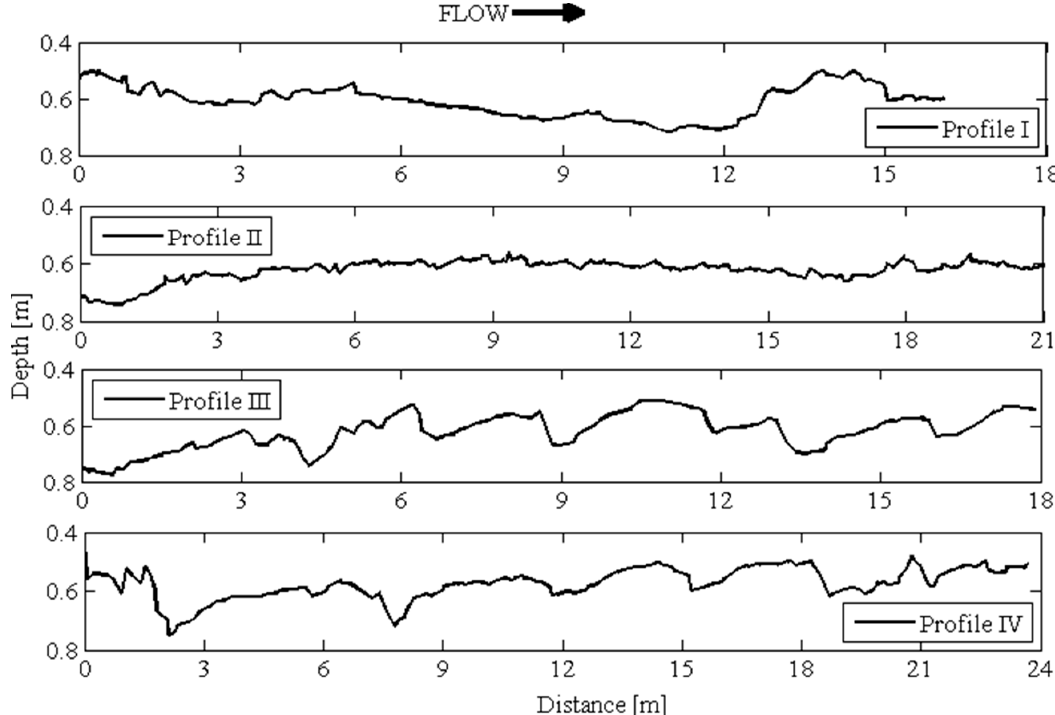
Figure 7. Bed elevation profiles made in the stream-wise direction in the Ś wider River. Please note that profile numbers increase with distance to the left bank.